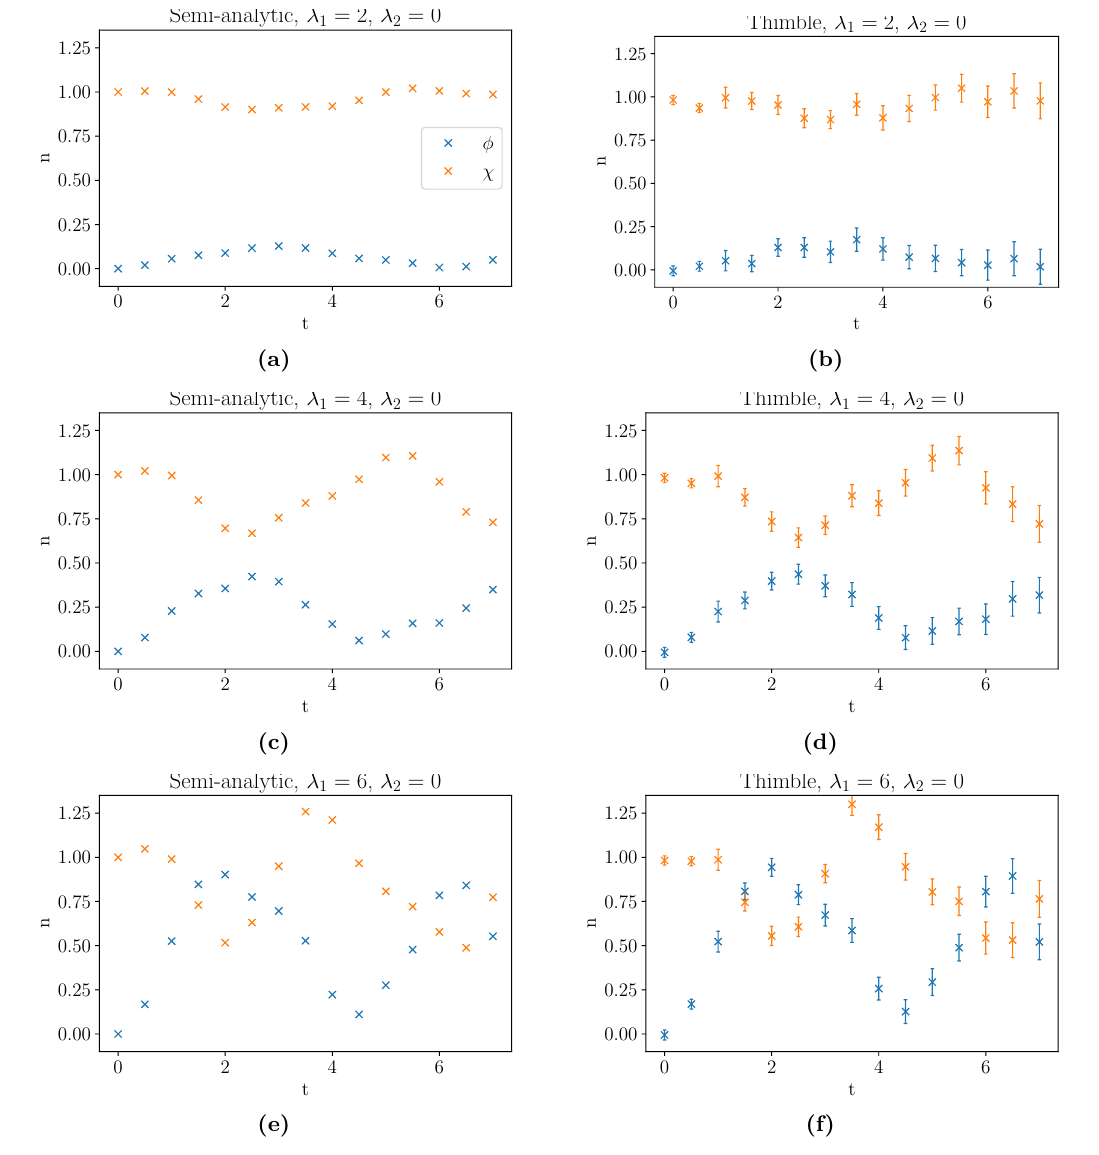
Figure 10. Semi-analytic (left) and Thimble (right) occupation numbers for two fields mixing with different values of the parameter λ 1 , λ 2 = 0